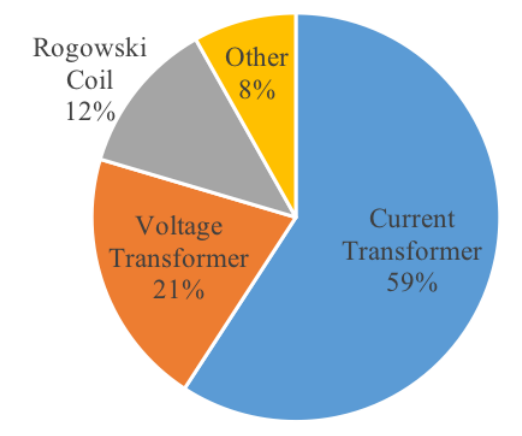
Figure 4. Types of sensor used by e-monitors.